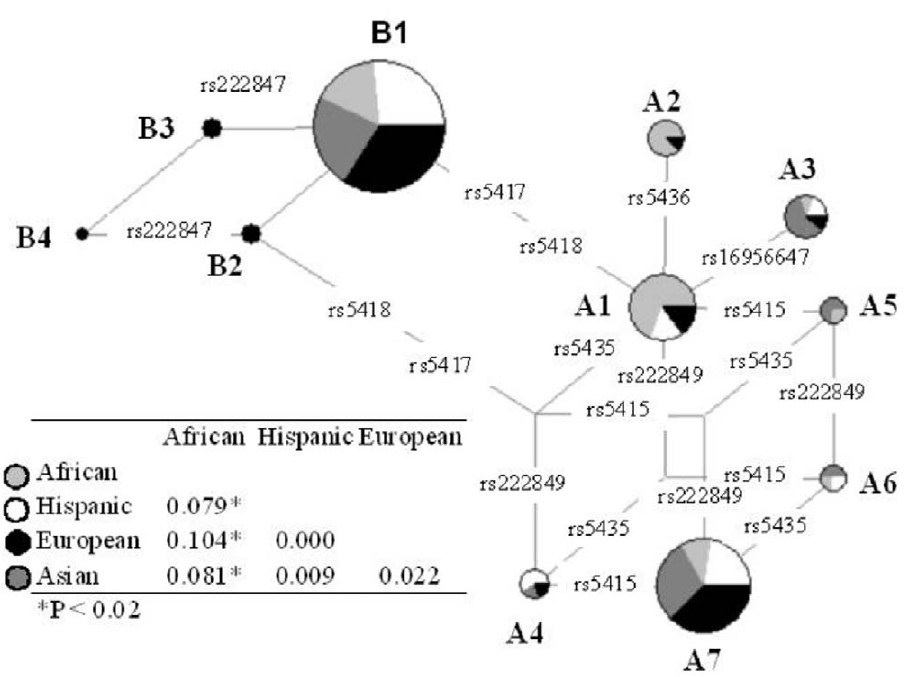
Figure 2. Reduced Median Network of SLC2A4 haplotypes inferred in the re-sequencing panel and matrix of pairwise F ST . Haplotypes were inferred from the 8 polymorphisms with a MAF , 0.05 in at least one population. Each circle represents a different haplotype, its size is proportional to its relative frequency and the presence in each population is indicated with different gray tonalities. Base substitutions are indicated along branches. The reticulated network reflects the action of recombination or recurrent